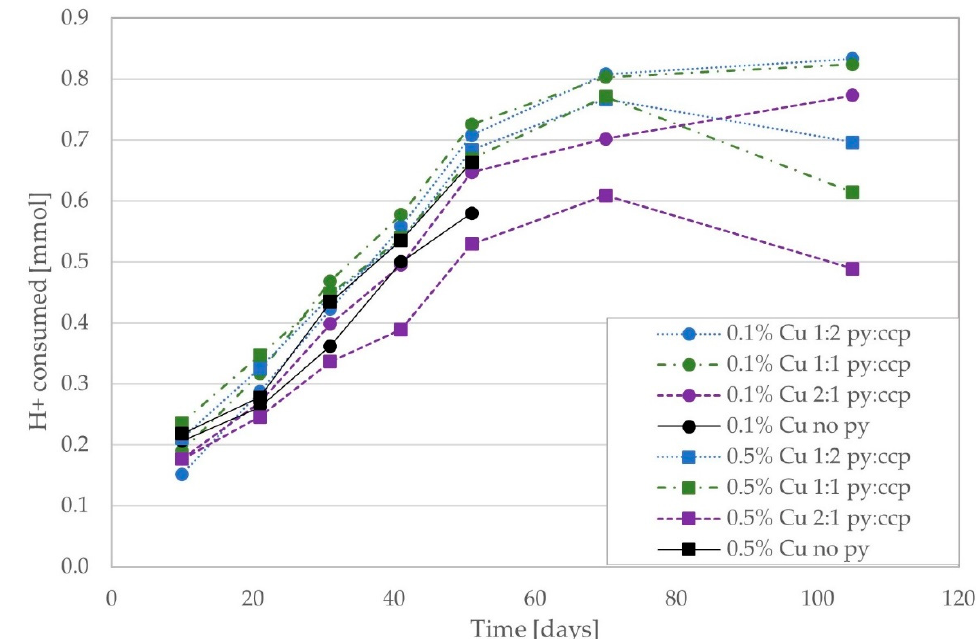
Figure 2. Cumulative net acid consumption of the biotic systems based on pH measurements is generally consistent with a buffered system, i.e., the lower pKa value for phosphate = pH 2.16. Cell counts in sampled liquor were within the same order of magnitude as the original inoculum (ca. 10 6 bacteria/mL) at all sampling time points, so with every sampling, approximately 75% of the ‘original’ planktonic bacteria were washed out, with the planktonic culture subsequently recovering. Cell numbers on chalcopyrite and sand were approx. 10 5 –10 6 cells/mm 2 for regions with attached cells, although there were proportionately more empty areas (overall, possessing ca. 2 × 10 3 cells/mm 2 ). Therefore, for the chalcopyrite system, cells were roughly distributed between planktonic, chalcopyrite-bound and sand-bound surfaces. In contrast, biofilm cell numbers dominated the pyrite-containing systems, with a conservative estimate of biomass corresponding to ca. 10 7 total planktonic numbers (10 6 cells/mL in 10 mL of column liquid volume) and 10 8 –10 9 cells as